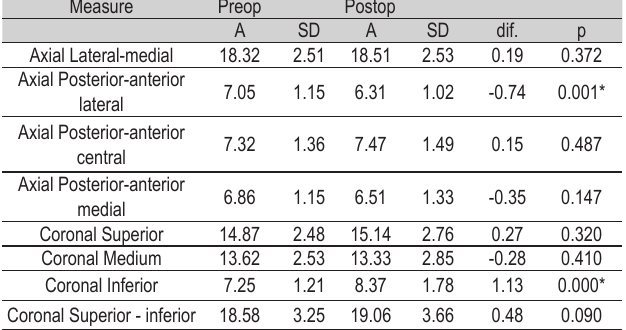
Table 1 - Average (A), standard deviation (SD), difference between preoperative (Preop) and postoperative (Postop) averages (dif), paired t-test result (p), when the right and left condyles were considered together (same individual) (*p<0.05).